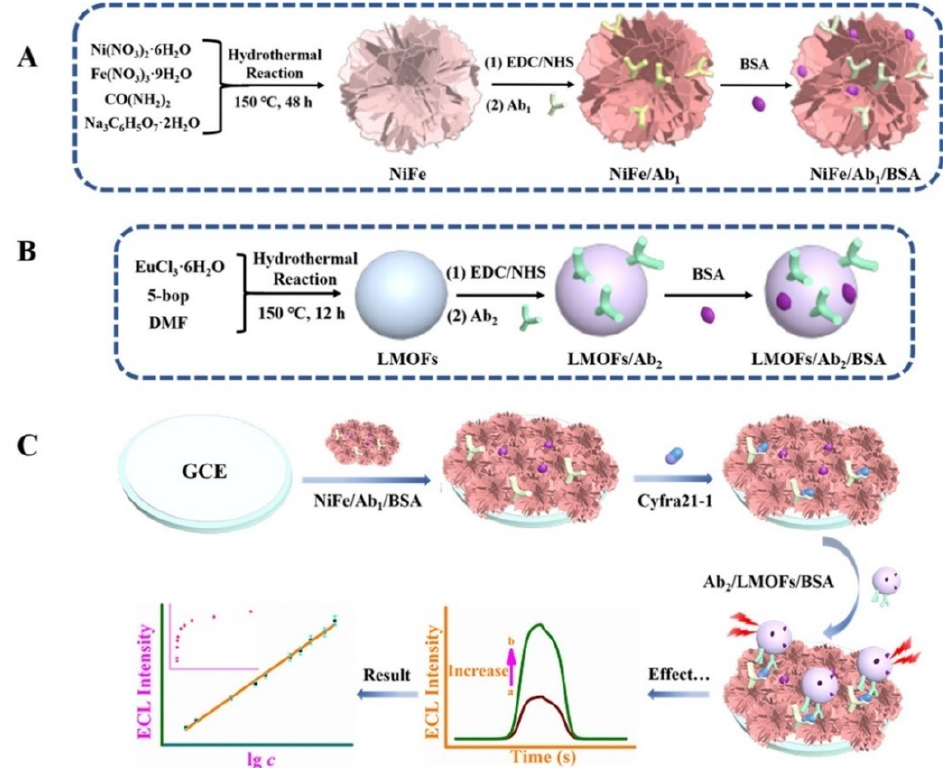
Figure 3. Preparation of NiFe Complex/Ab 1 /BSA Bioconjugate ( A ), Ab 2 /LMOFs/BSA Bioconjugate ( B ), and Formation Route of the Suggested Signal-Enhanced ECL Model ( C ) [61]. Copyright © 2021, American Chemical Society.